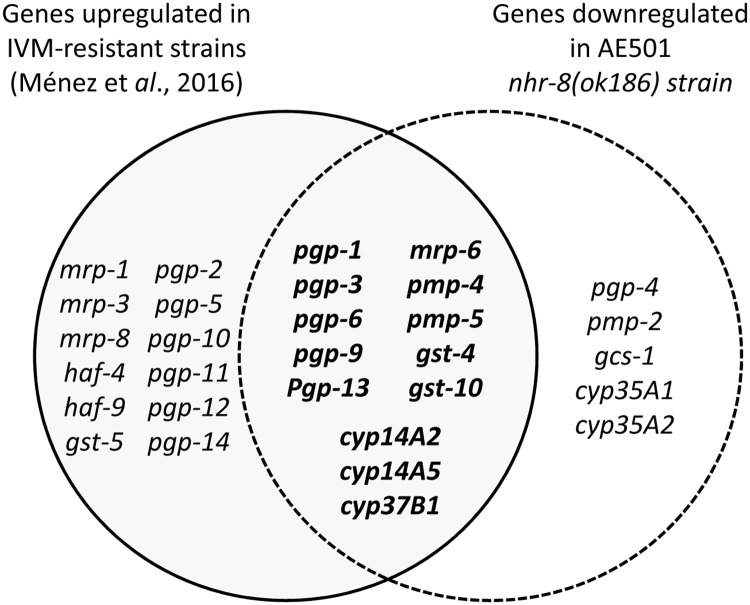
Venn diagram showing the overlap between genes upregulated in IVM-resistant strains and genes downregulated in nhr-8(ok186) mutants.